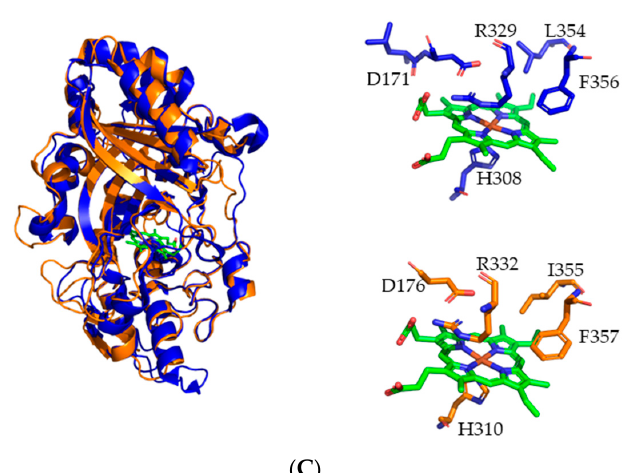
Figure 1. Amino acid sequence and structure alignments between SaDyPs and representative DyP-type peroxidases. ( A ) SaDyP1, SaDyP2 and DyP from B. adusta . ( B ) SaDyP3, SaDyP4 and EfeB. Residues with two or more matches are indicated with black fill. The unique GXXDG motifs of DyP-type peroxidases are surrounded by a red line. Catalytic aspartate of DyP is indicated by red arrowheads [6]. Blue arrowheads show four amino acid residues that form the hydrogen peroxide binding pocket of DyP [21]. ( C ) Homology modeling of SaDyP1 using SWISS-MODEL. Orange, the model of SaDyP1; blue, DyP. A model constructed using an ancestral class V DyP-type peroxidase (PDB:7anv) as a template. Left, structure alignment of the model of SaDyP1 and DyP (PDB: 3afv). Upper-right, enlarged view around heme in DyP (PDB: 3afv). Catalytic aspartate and four amino acid residues highly conserved around heme in DyP-type peroxidase were indicated. Bottom, enlarged view around heme in the model of SaDyP1. Amino acid residues of SaDyP1 model corresponding in DyP (upper-right) were shown. The drawing and alignment were by the PyMOL Molecular Graphics System, Version 2.5 Schrödinger, LLC.